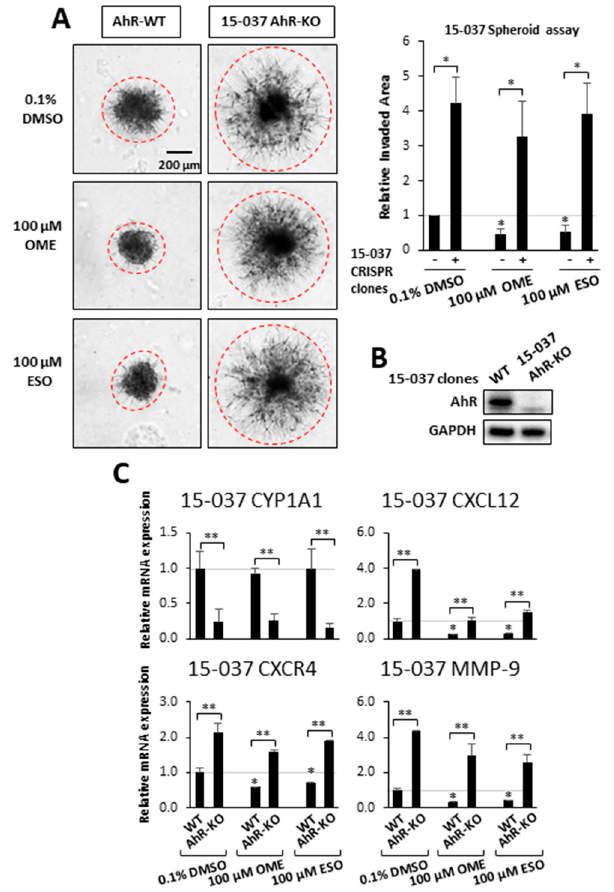
Figure 3. E ff ects of OME and ESO on AhR-dependent invasion and gene expression in 15-037 and 15-037 AKO-19 cells. Wild-type 15-037 and 15-037 AKO-19 cells were treated with DMSO, 100 µ M OME, and 100 µ M ESO and spheroid cell invasion was determined and quantitated ( A ) as outlined in the Materials and Methods. AhR expression in 15-037 / 15-037 AKO-19 cells were determined by Western blots of whole cell lysates ( B ). E ff ects of DMSO (set at 1.0), 100 µ M OME, and 100 µ M ESO on gene expression in 15-037 and 15-037 AKO-19 cells ( C ) were determined by real time PCR as outlined in the Materials and Methods. Results ( A , C ) are expressed as means ± SD for at least 3 determination for each treatment group and significant ( p < 0.05) e ff ects by the compounds alone (*) and attenuation of these response after silencing AhR (**) are indicated.